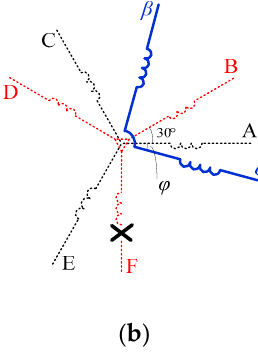
Figure 5. Physical model of stator winding. ( a ) Asymmetric five-phase winding; ( b ) Equivalent two-phase winding.